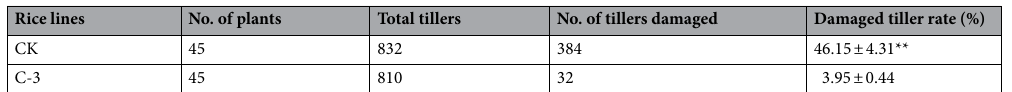
Table 1. Insect resistance assay of the transgenic rice in the greenhouse. Means (± SE) within a column followed by different letters are significantly different (T-test, ** P < 0.01).